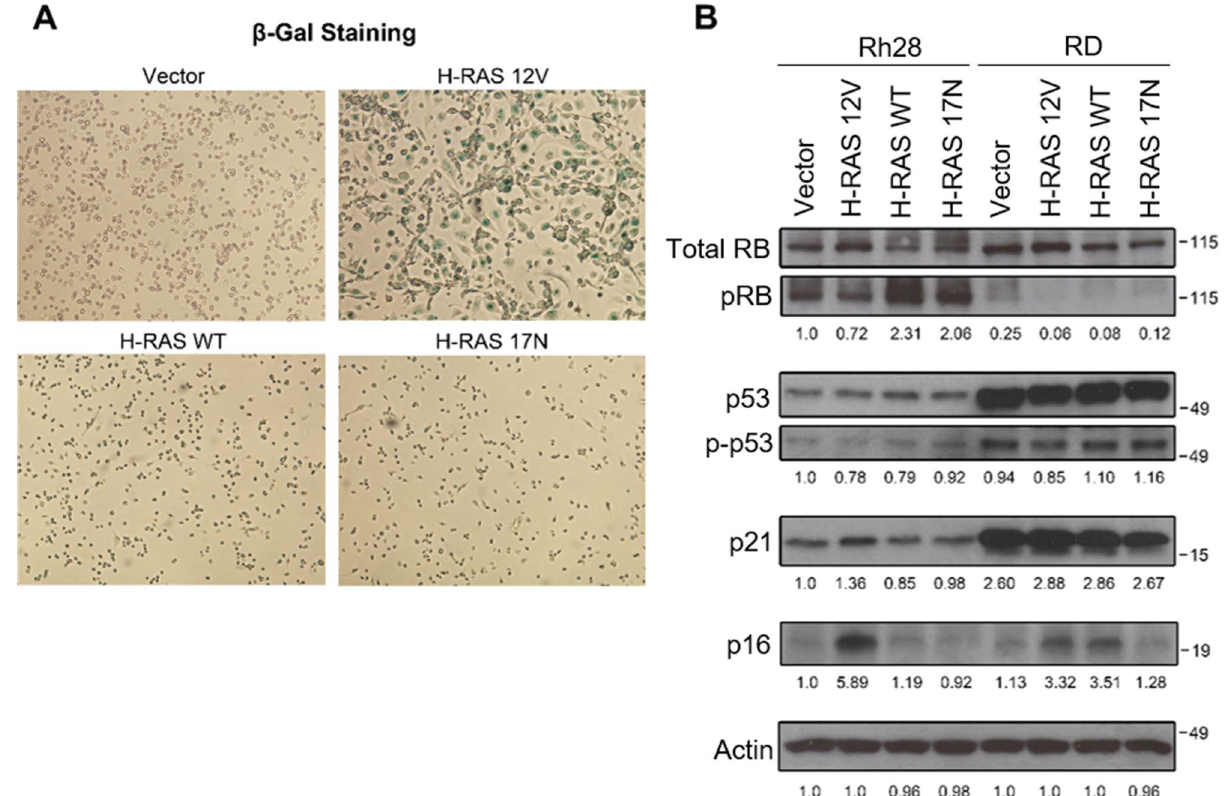
Figure 4. Expression of oncogenic H-RAS induces senescence in Rh28 aRMS cells. ( A ) To assess senescence, Rh28 cells expressing H-RAS mutants were stained for β-gal. Representative images are shown (magnification ×100). Expression of oncogenic H-RAS increased β-gal staining whereas the other H-RAS mutants did not. ( B ) Expression of RB and p53 pathway members was examined by immunoblot in both Rh28 and RD cells expressing H-RAS mutants. Representative blots are shown. While the expression of oncogenic H-RAS led to inconsistent changes in the levels of total RB, total p53, and phospho-p53 over multiple replicates, p16 and p21 were consistently elevated and pRB levels were decreased with the expression of oncogenic H-RAS in aRMS Rh28 cells; this effect was not seen to the same degree in R-eRMS RD cells. Actin used as a loading control. Densitometry quantitation shown below blots and is normalized to Rh28 Vector